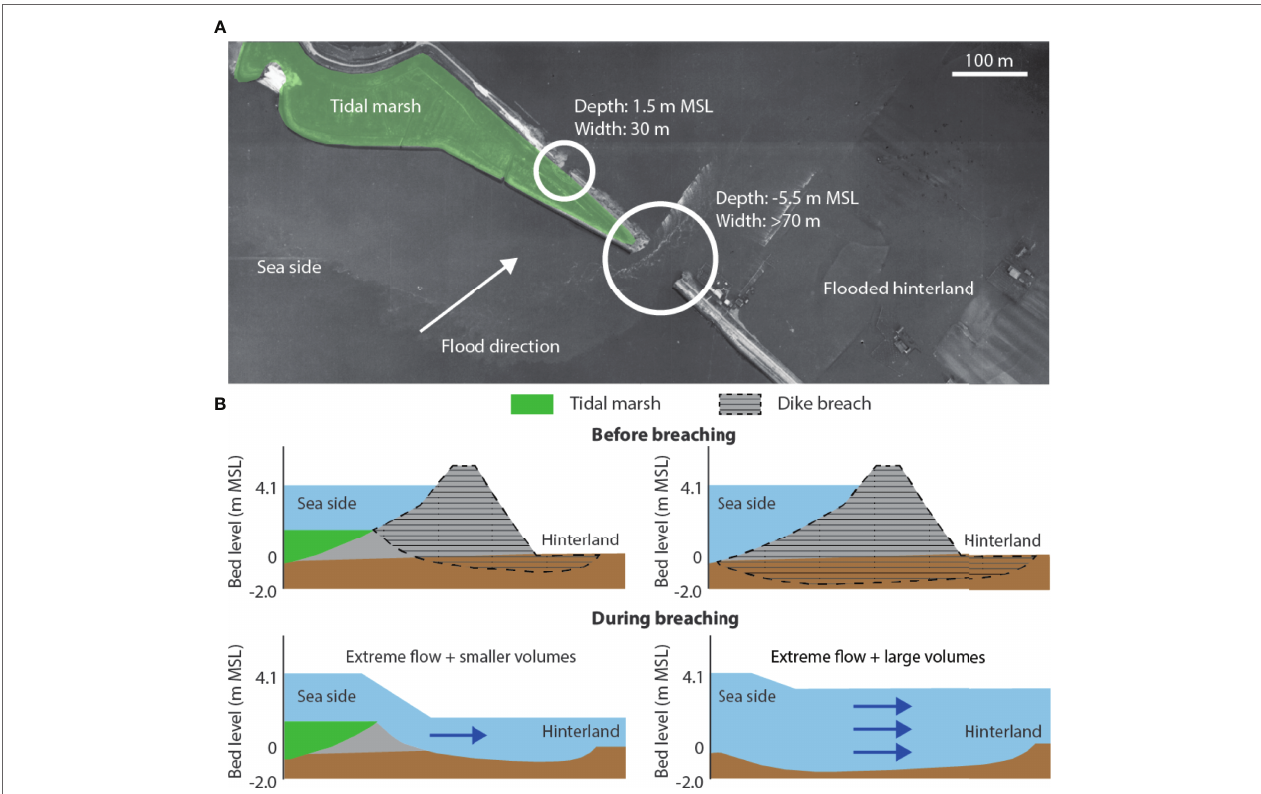
FIGURE 1 | Hypothetical explanation of the protective function of tidal marshes in front of a dike breach. An aerial image of two neighboring dike breaches (white circles) at the former Haringvliet estuary (the Netherlands) during the North Sea flood in 1953 (A) . Illustration of how flow velocities and water volume differ in case of a dike breach with tidal marsh (left) and without tidal marsh in front of the dike (right) (B) . Credit: Figure adapted from Zhu et al. (2020a)